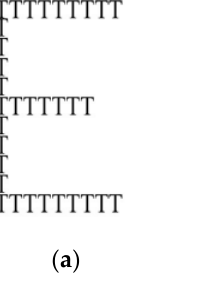
Figure 2. Navon task and stimuli used. The picture shows an example of stimuli ( a , b ) and the paradigm ( c ) used.